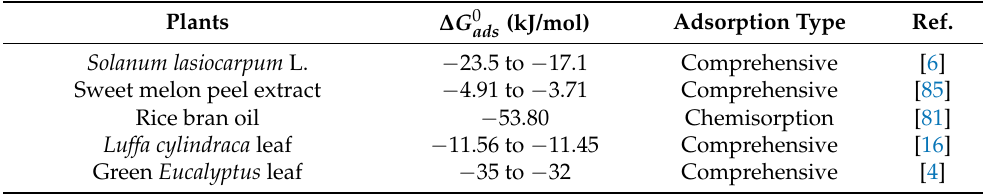
Table 3. Standard free energy for various plants-based inhibitors.